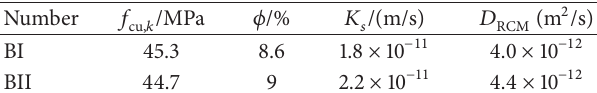
Table 2: Strength, porosity, saturated hydraulic conductivity, and chloride diffusion coefficient of the